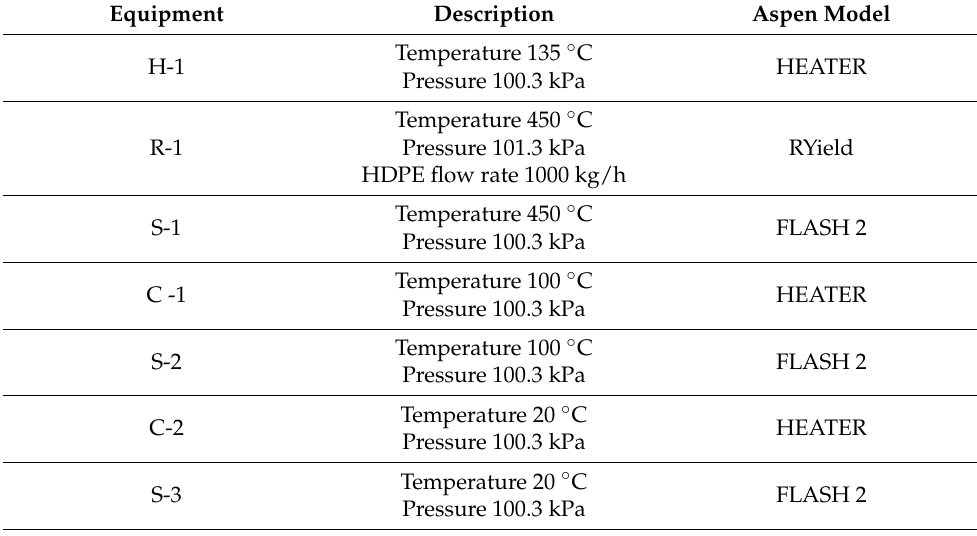
Table 11. Process model for the pyrolysis of HDPE waste plastic. Equipment